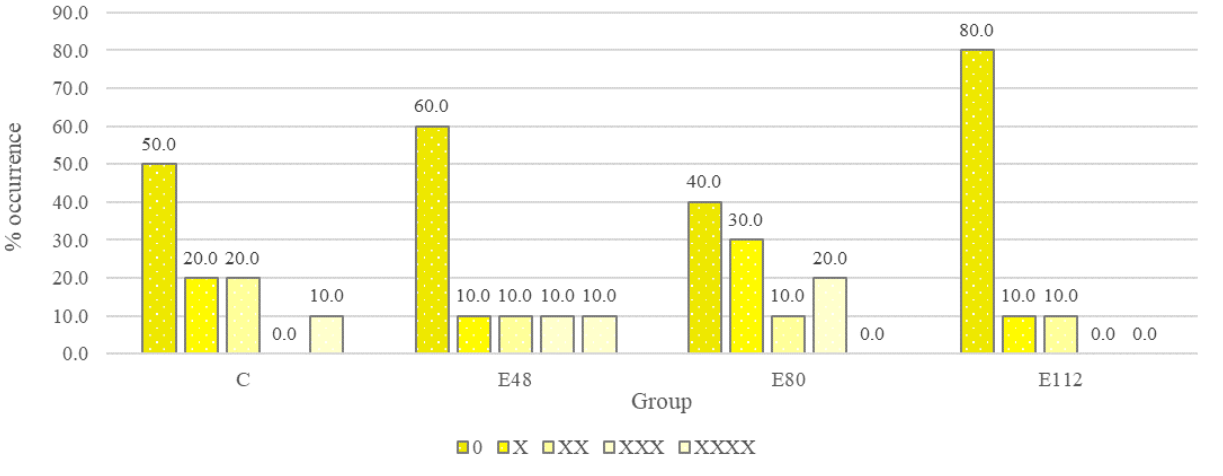
Figure 7. Distribution of levels of positive samples by level of occurrence at the end of the experi- ment ( n = 10–14). 3.4. Level of Non-Specific Resistance The study of nonspecific resistance of experimental animals in the control and exper- imental groups at the end of the experiment revealed significant inter-group differences (at the beginning of the experiment, the differences in the studied parameters between the groups were not significant) (Table 4). Feeding on BFA increased the serum lysozyme con- centration of experimental cows by 1.01–2.91 mkg/mL compared to the control ( p < 0.001).